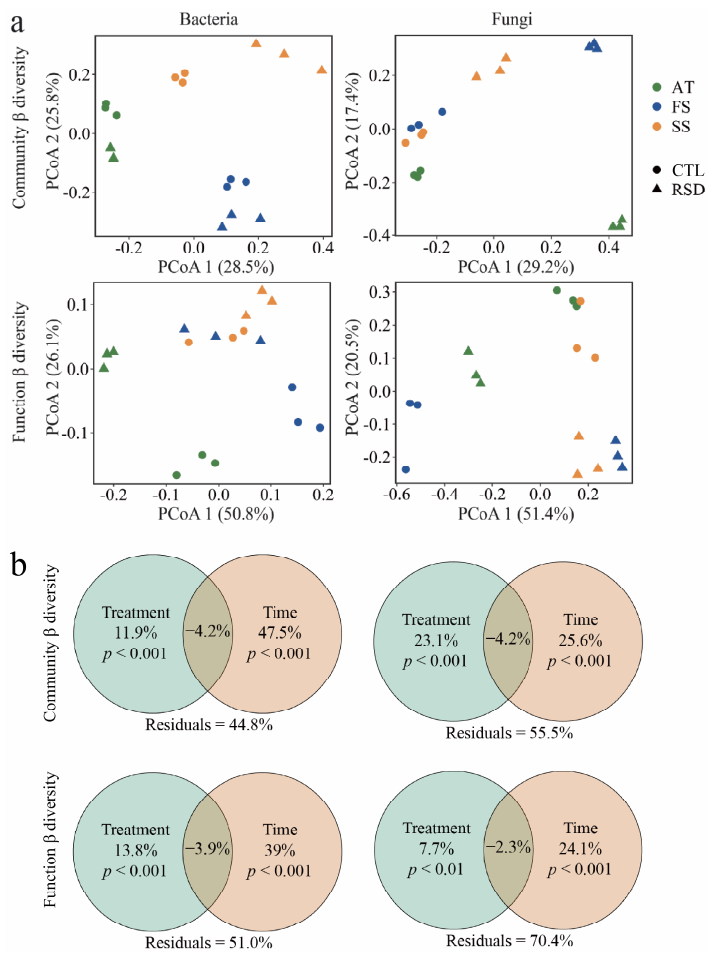
Figure 2. Dissimilarities in soil microbial communities and functions and their contributors. Principal coordinates analyses (PCoAs) ( a ) of soil microbial communities and functions were determined based on Bray − Curtis distances in different treatments and time points. The relative contributions and significant effects of treatments and time points to the dissimilarities in microbial communities and functions were calculated using VPA and PERMANOVA analyses ( b ). CTL, untreated soil; RSD, soil incorporated with molasses, irrigated to saturation, and covered with plastic film. AT, FS, and SS indicate the soils collected from after treatment, the first season, and the second season,